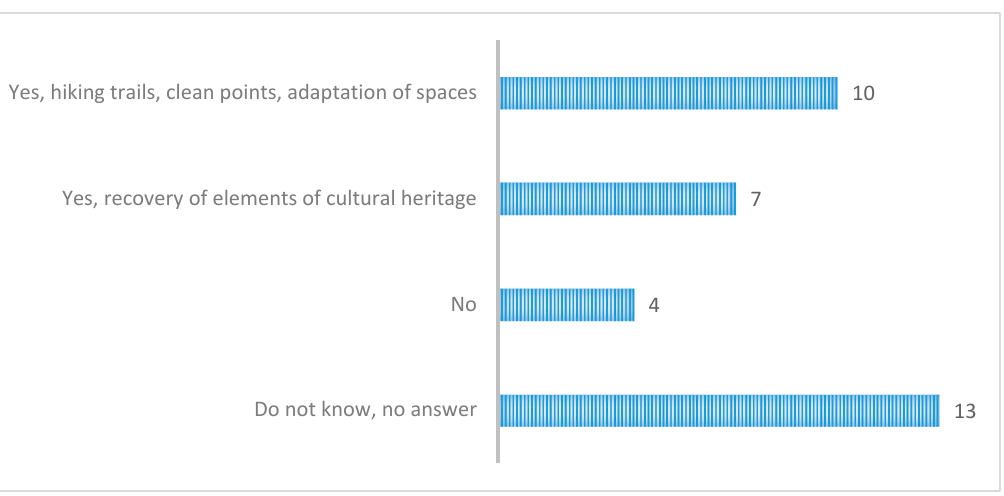
Figure 8. Do you think Proder has reinforced the regional identity? Source: Own elaboration. Land 2020 , 9 , x FOR PEER REVIEW